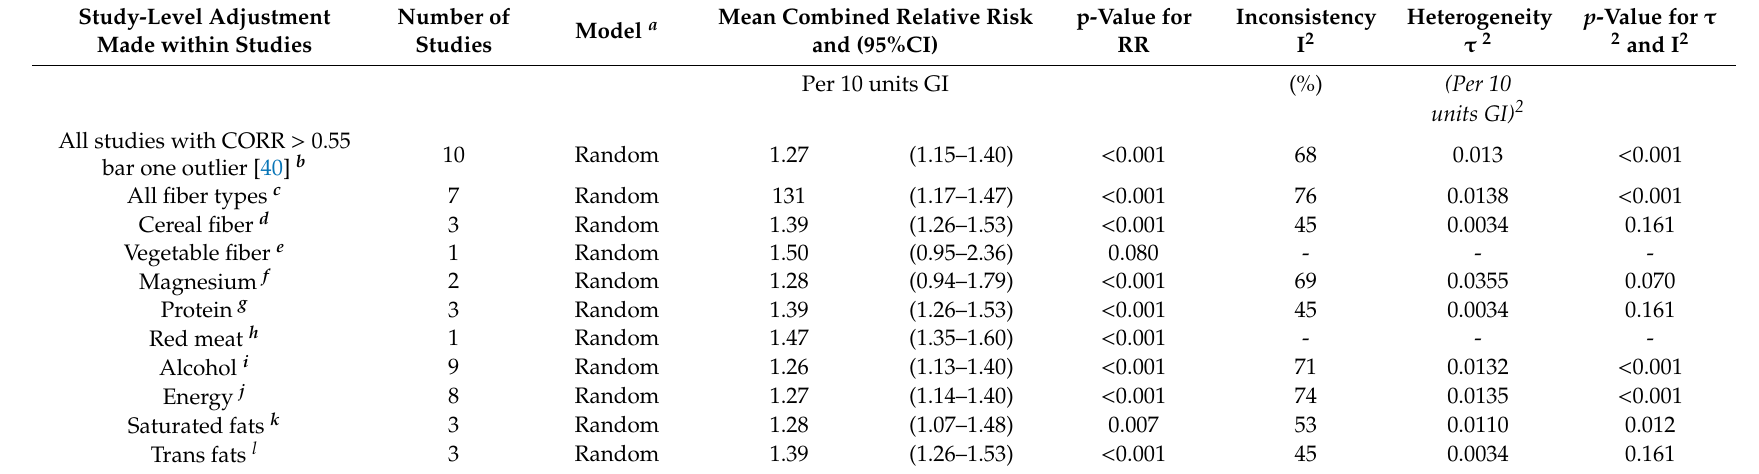
Table 2. The type 2 diabetes–glycemic index dose-response risk relation in studies making study-level adjustments for specific nutrients. Studies with CORR > 0.55 were included in this